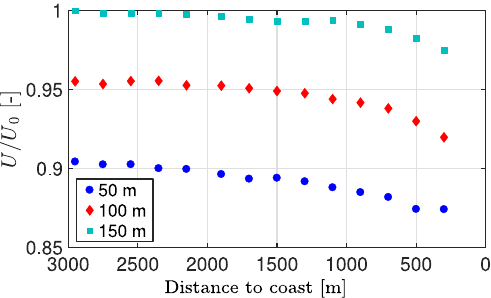
Figure 7. Normalised coastal wind gradient along the dual-set-up transect of reconstructed wind speed measurements for westerly winds at 50, 100 and 150ma . m . s . l . for neutral periods. U 0 is the mean wind speed at 2950m to the coast at 150m